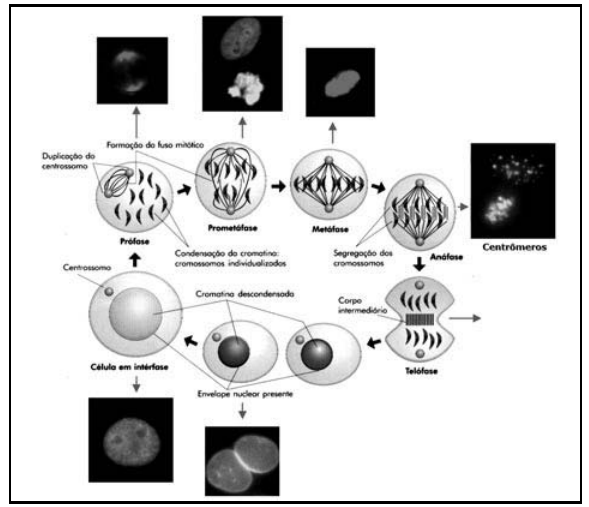
Figura 3 – Imagem esquemática de ciclo celular e exemplos de padrões de ANA- HEp-2 associados às diferentes fases